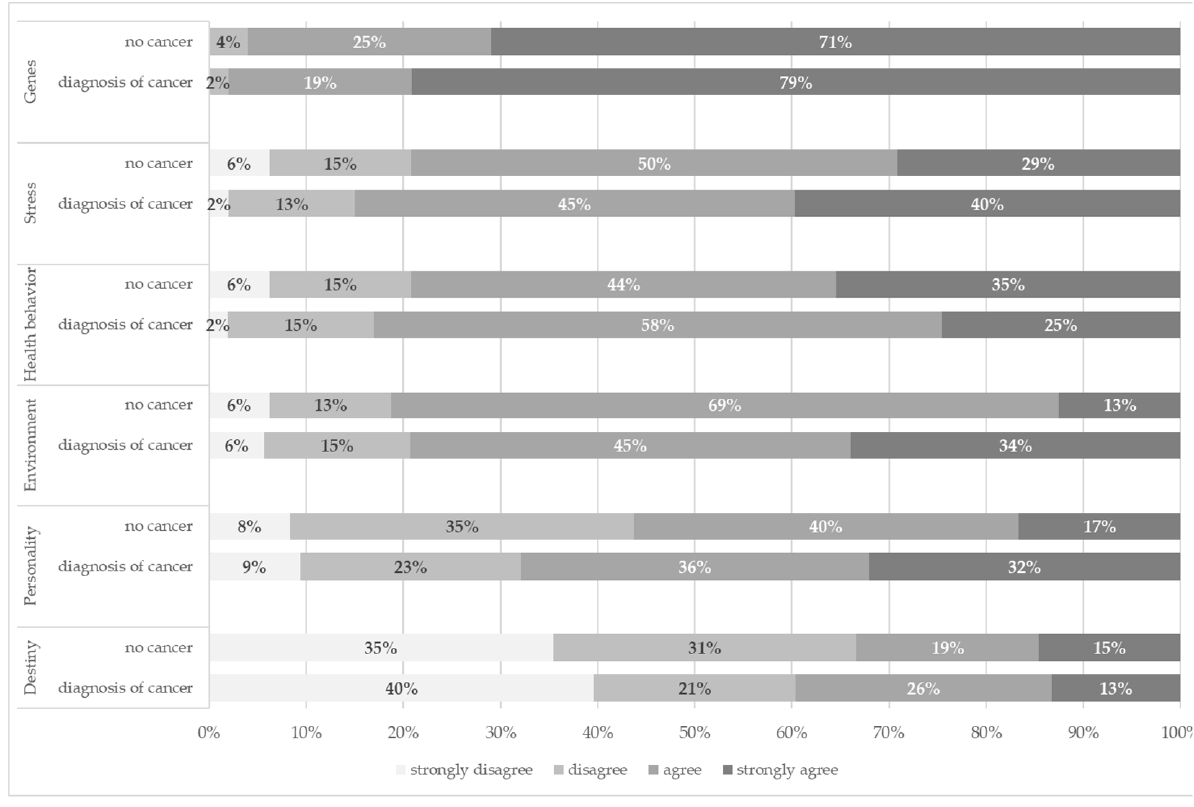
Figure 1. Distribution of causal attributions according to cancer diagnosis ( N = 101).